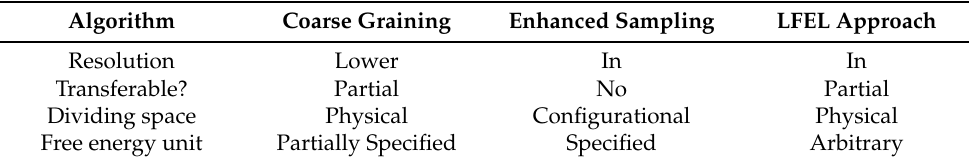
Table 2. Commonality and difference among three types of